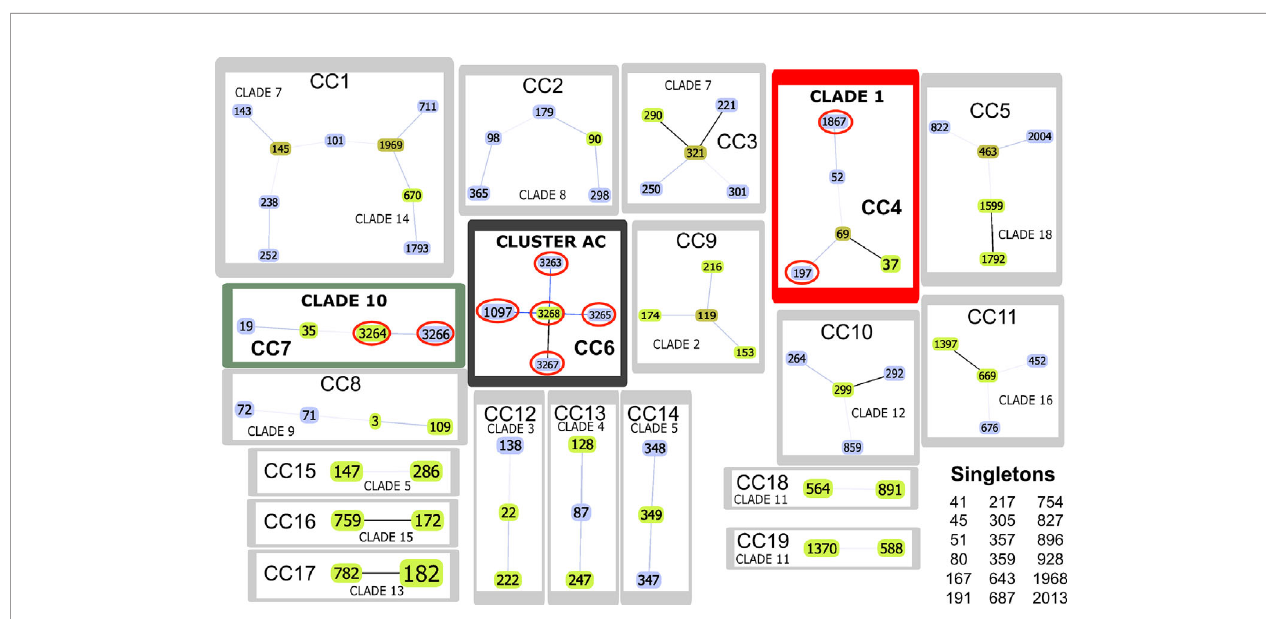
FIGURE 3 | goeBURST analysis. The Colombian atypical isolates (red line ovals) were found in CC4 (framed in red), CC6 (black frame) and CC7 (green frame). Link colours: black links drawn without recourse to tiebreak rules; blue links drawn using tiebreak rule 1 (amount of single locus variations (SLV)); grey links drawn regarding triple locus variation (TLV) (lighter grey). Sequence type (ST) node colours: light green - founder group; dark green - founder sub-group; light blue - common